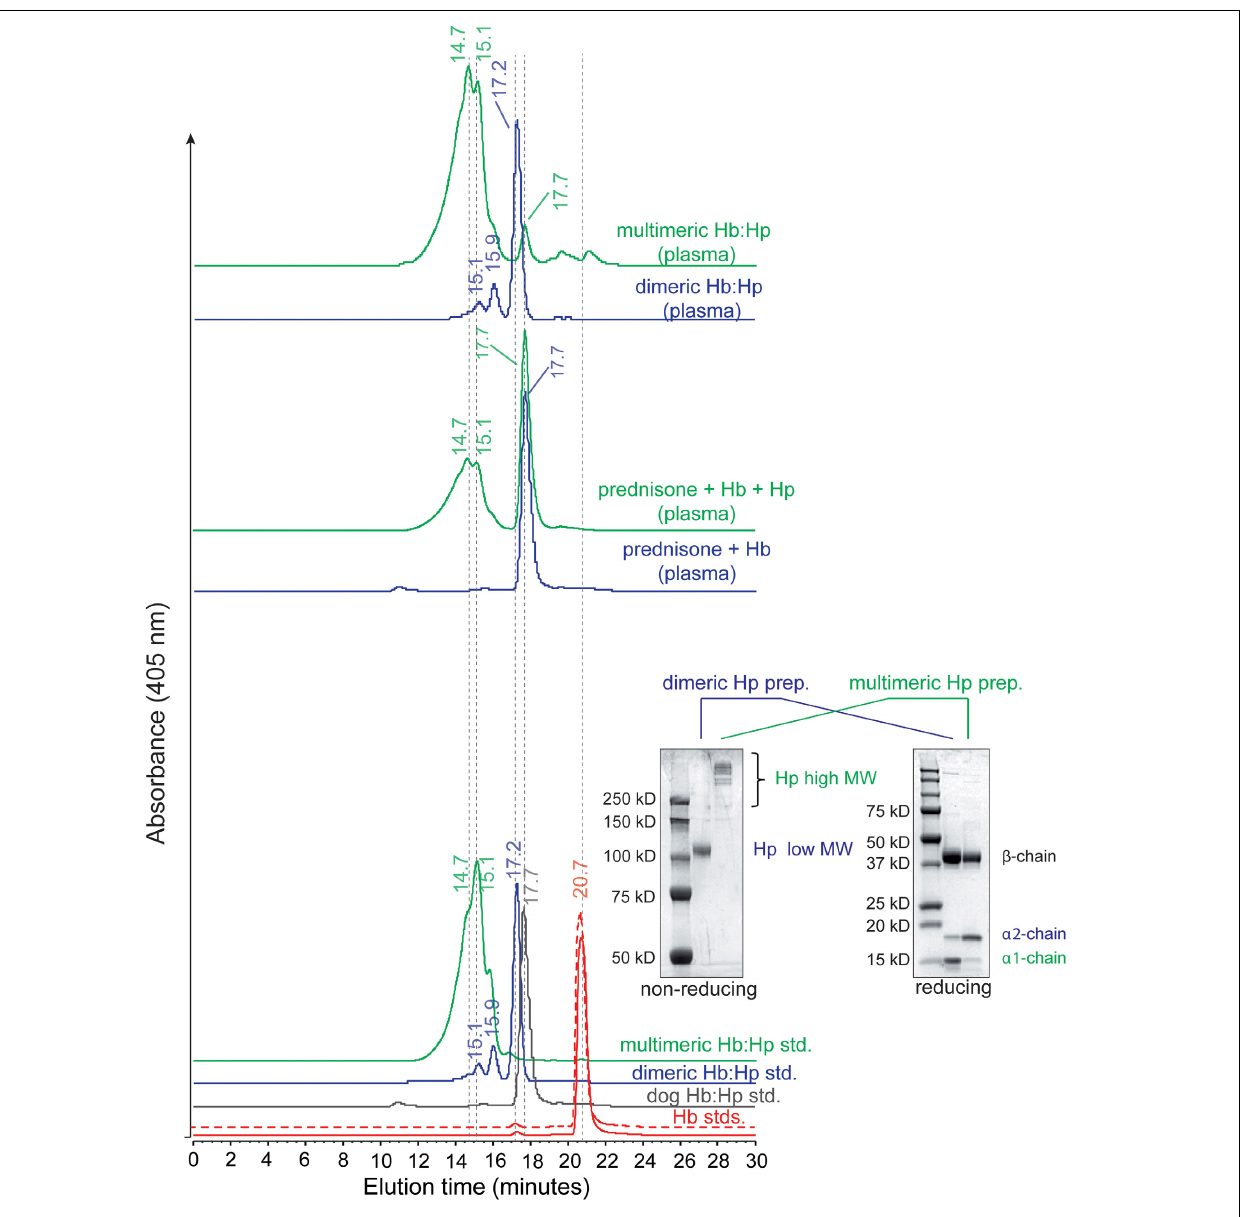
non-reducing and reducing conditions. (Middle panel) shows representative plasma samples from prednisone pre-treated animals following Hb exposure ( ± ) multimeric Hp. (Top panel) shows the distribution of Hb bound to Hp after dimeric and multimeric human Hp dosing.